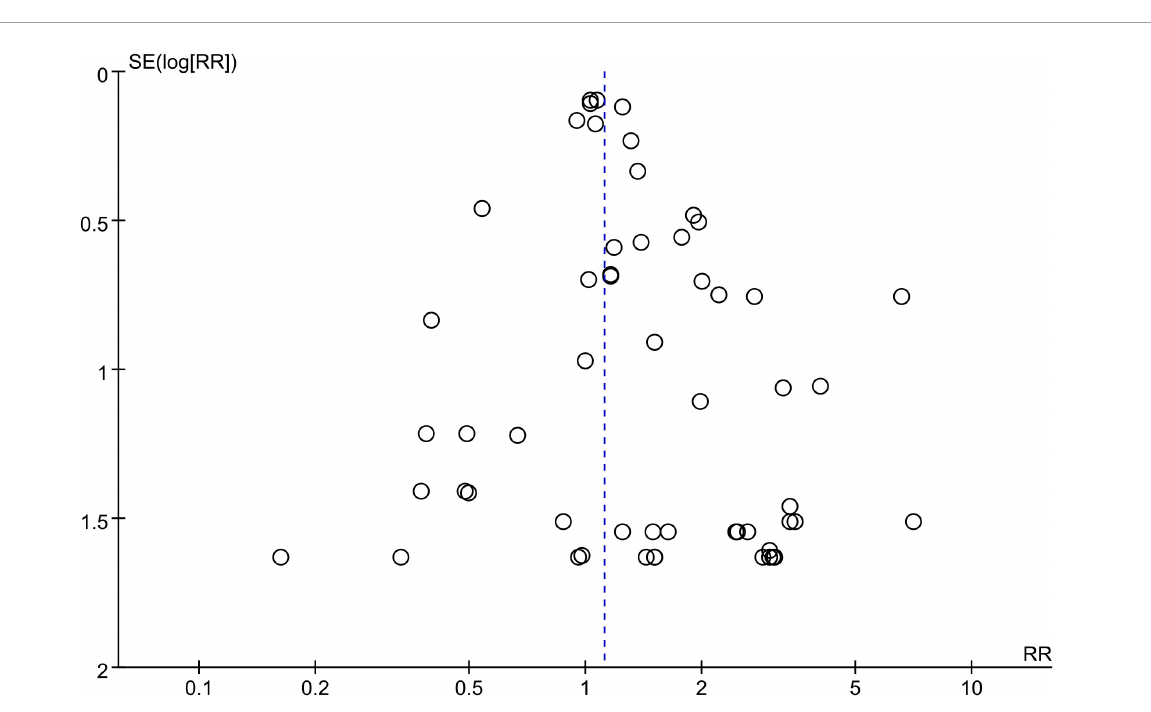
FIGURE3 Funnel plot of publication bias for hypovolemia comparing the SGLT2 inhibitors group vs. the placebo